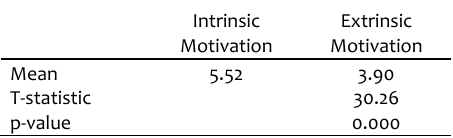
Table 3. t ‐ Test intrinsic and extrinsic